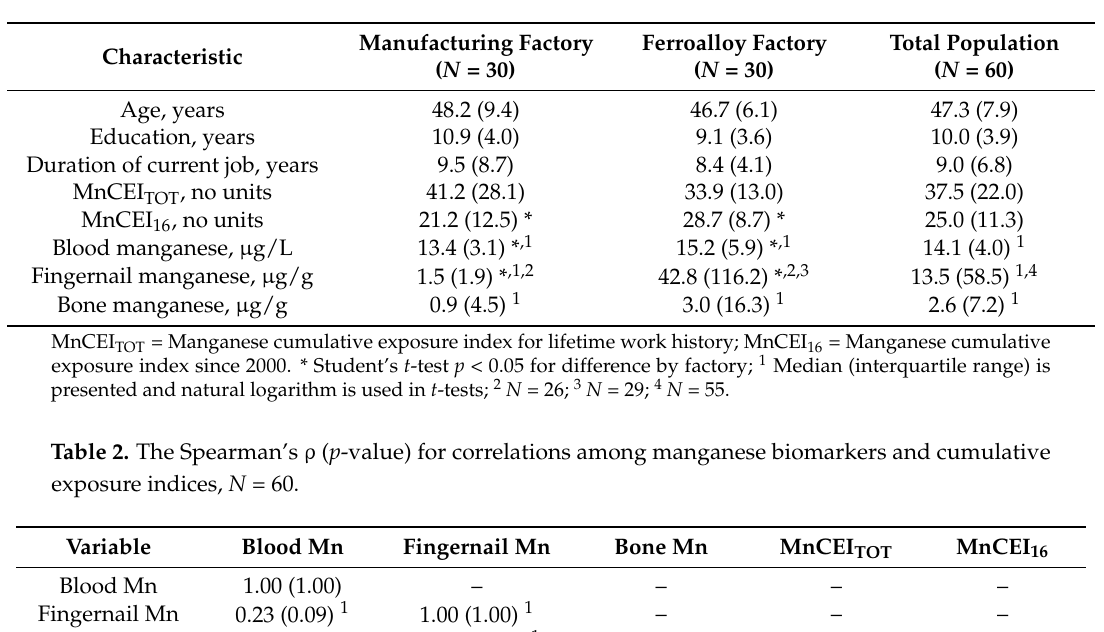
Table 1. The means (standard deviations) for the selected population characteristics stratified by factory.